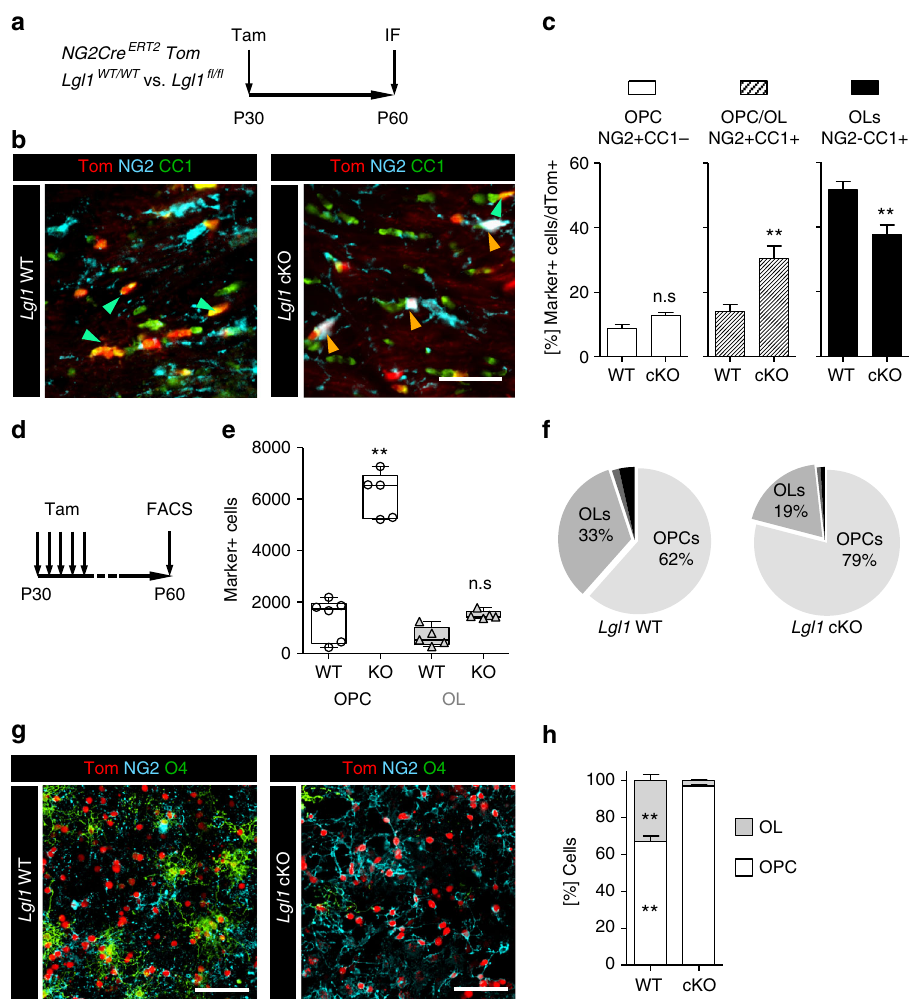
Fig. 2 Lgl1 knockout blocks OPC to OL differentiation. a Schematic of approach for clonal labeling and NG2 Cre-conditional deletion of Lgl1 in OPC. b Representative triple immunostaining of corpus callosum of Lgl1 WT and Lgl1 cKO from mice treated as in ( a ) for red fl uorescent protein (Tom), OPC marker NG2 and differentiation marker CC1. Green arrows point to Tom + CC1 + oligodendrocytes. Orange arrows in the Lgl1 cKO panel point to Tom + NG2 + CC1 + cells. Scale bar: 50 µ m. c Quanti fi cation of NG2 + , CC1 + , and NG2 + CC1 + cells ratios amongst Tom + cells. Data are represented as mean ± s.e.m. from the analyses of 4 Lgl1 WT vs. 4 Lgl1 cKO treated mice (** p < 0.01, Mann – Whitney test). d Schematic of broad deletion of Lgl1 in P30 mice followed by FACS at P60. e Plot showing quanti fi cation of OPC (white) and OL (gray) in mice treated following scheme in ( d ). Data are represented as box & whiskers ± s.e.m. from the analyses of 6 Lgl1 WT vs. 5 Lgl1 cKO treated mice (** p < 0.01, Mann – Whitney test). f Pie charts of quanti fi cation for NG2 + , O4 + , astrocyte marker GLAST + and neuroblast marker CD24 + cells amongst Tom + cells, after Lgl1 knockout at P60 (see also Supplementary Fig. 2b). Data are represented as percentages from the analyses of 6 Lgl1 WT vs. 5 Lgl1 cKO mice (OPC p < 0.01; OL p < 0.01). g Representative immunostaining for NG2 and O4 of OPC and OL isolated from GFAP-Cre, Tom , Lgl1 wt/wt and, GFAP-Cre ERT2 , Tom , Lgl1 fl / fl mice. Scale bars: 100 µ m. h Quanti fi cation of NG2 and O4 cells amongst all red fl uorescent protein (Tom) positive cells show that Lgl1 knockout strongly blocks the differentiation of OPC into O4 + OL. Data are represented as mean ± s.e.m. from the independent analyses of 4 Lgl1 WT vs. 4 Lgl1 cKO mice (** p < 0.01, Mann – Whitney